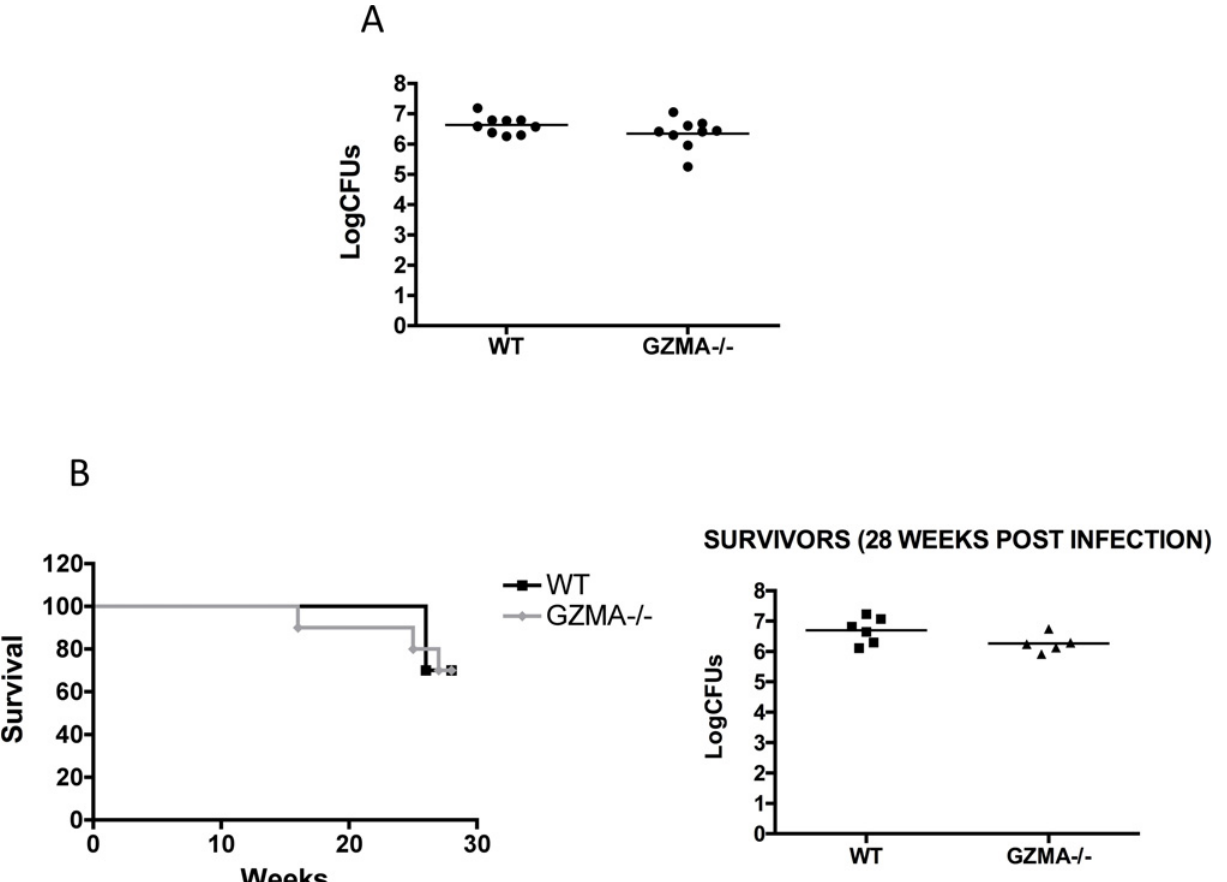
Fig 2. GZMA-/- mice are not more susceptible to M . tuberculosis infection. Groups of nine C57BL/6 wild-type or GZMA-/- mice were inoculated intranasally with a low-dose ( A ) or high-dose ( B ) H37Rv challenge. A , four weeks later bacterial burden in lungs was determined. A representative of two independent experiments is shown in the graph. B , animal survival (left panel) was determined according to pre-established endpoint criteria approved by an ethical committee. Data from one experiment are represented in a Kaplan-Meier survival curve. Lung bacterial burden in survivor animals was analyzed (right